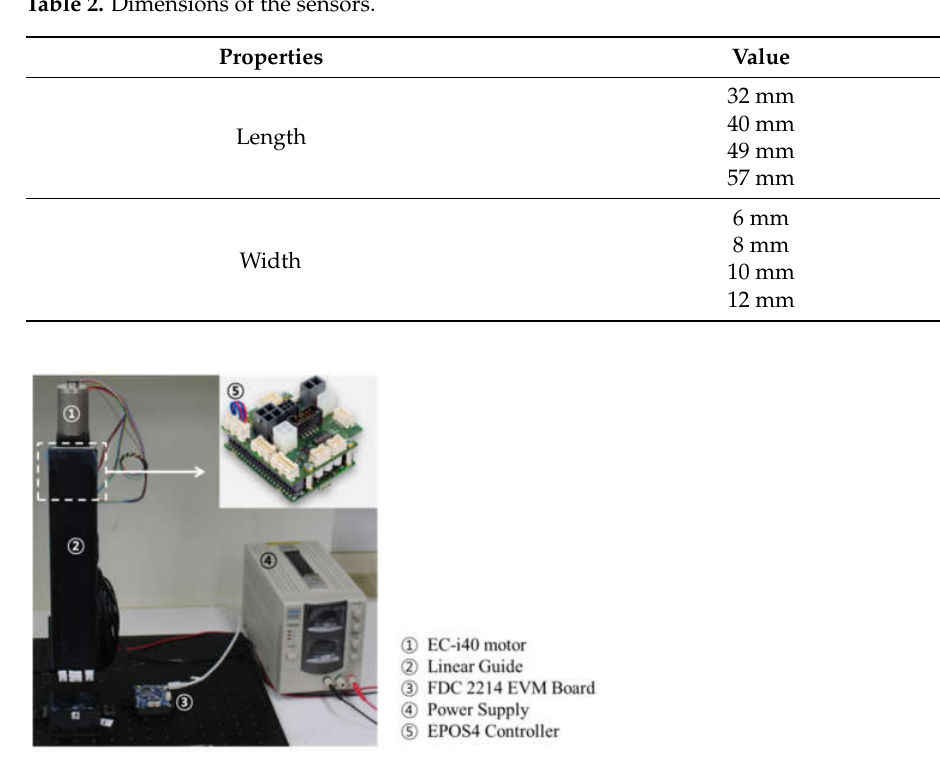
Figure 5. Linear actuator system for the sensor characterization experiment. The motor controller was placed behind the linear guide.